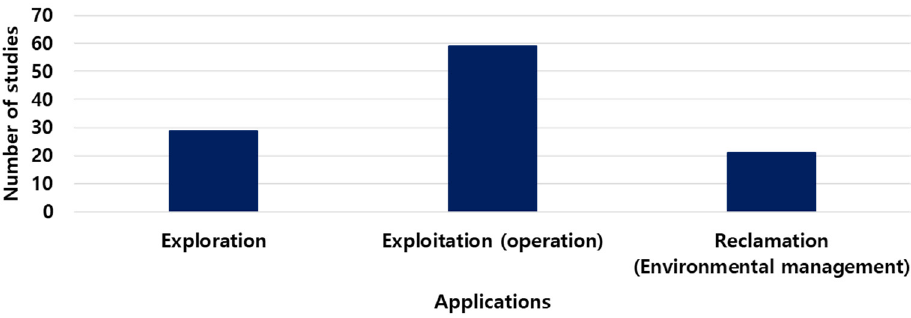
Figure 4. Number of studies based on the study of application fields.